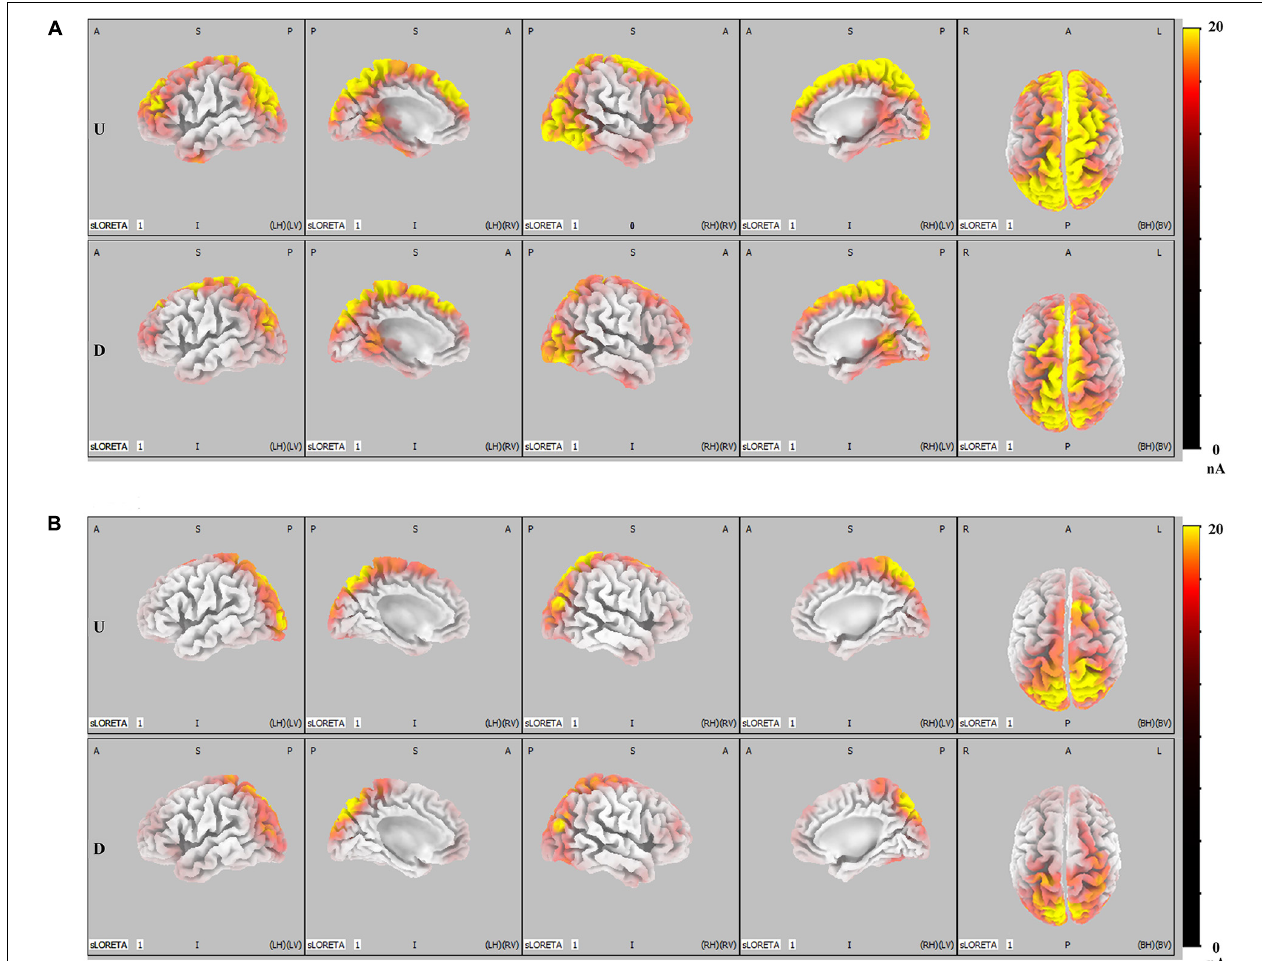
FIGURE 4 | LORETA probabilistic map in cortical activation of LPP and P300, for the IRA engendered and IRA un-engendered conditions. Red colors represent a greater activation, more evident from dark red to yellow. (A) The LPP. (B) The